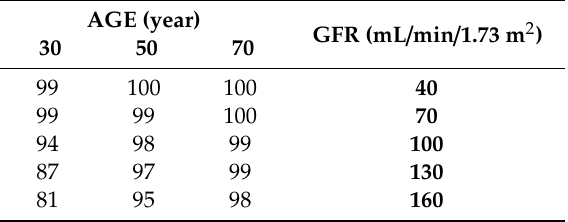
Table 5. Probability(%)toachieveatargetAUC / MIC = 100foradailydoseof750mgandaMIC = 0.5 mg / L, according to age and glomerular